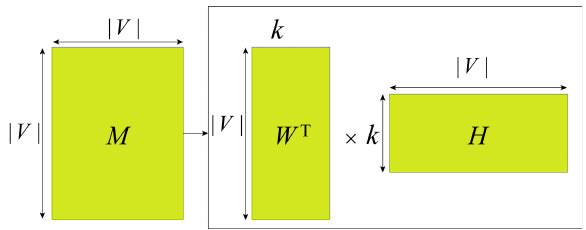
Fig. 2 Matrix factorization form of